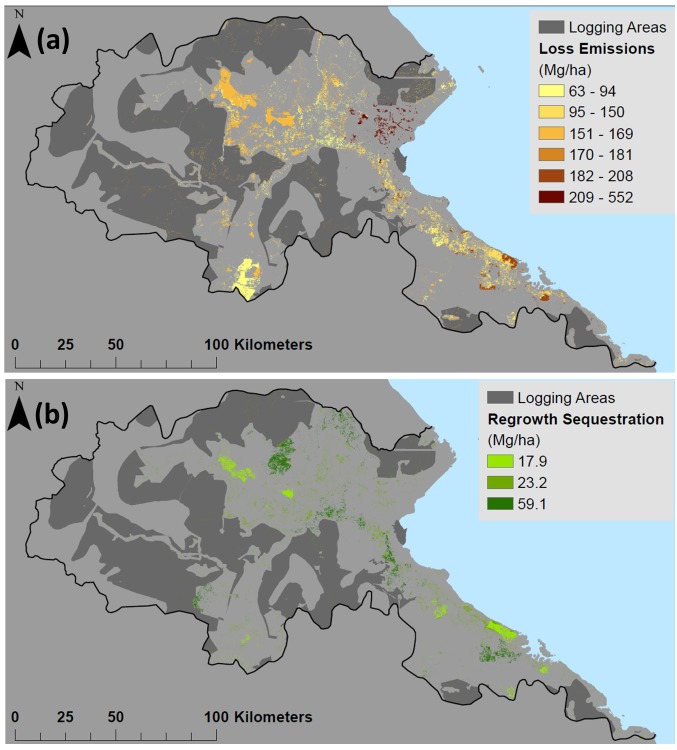
Spatial distribution of forest carbon flux, in MgC ha-1, is represented in (a) shades of brown for forest loss emissions, and (b) shades of green for forest regrowth.Monotone grey zones in (a) and (b) represent HA logging concessions–within which logging emissions and regrowth occurred, but specific locations are not known.